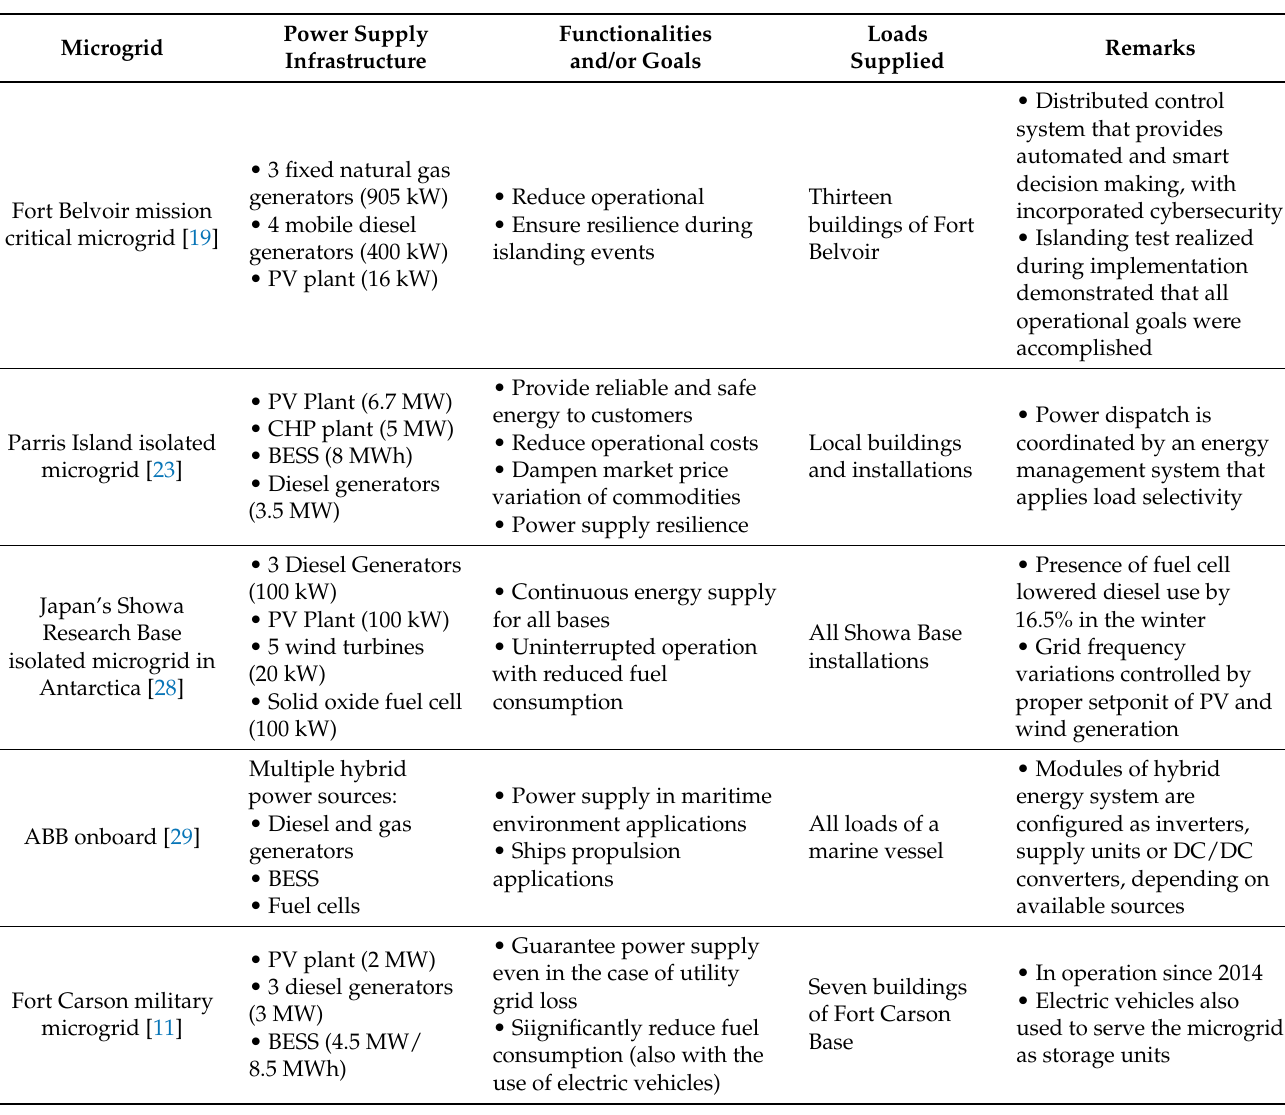
Table 1. Cases of microgrids for critical infrastructure